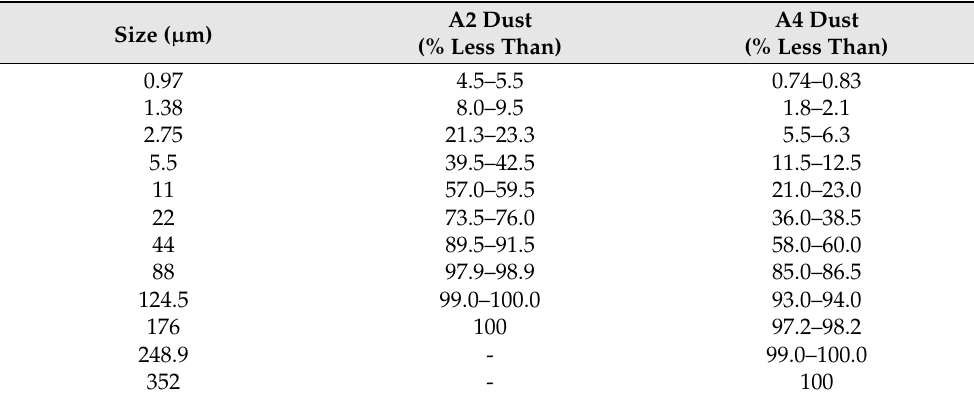
Table 2. Particle size distribution of Arizona test